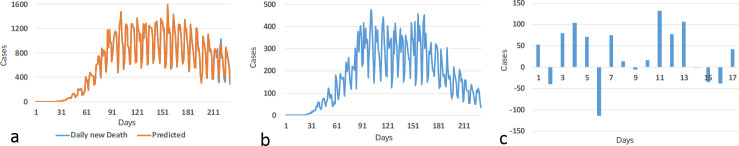
Brazil death cases.a) Death of prediction and confirmed per days, b) Death prediction with best government performance, c) Death prediction error.